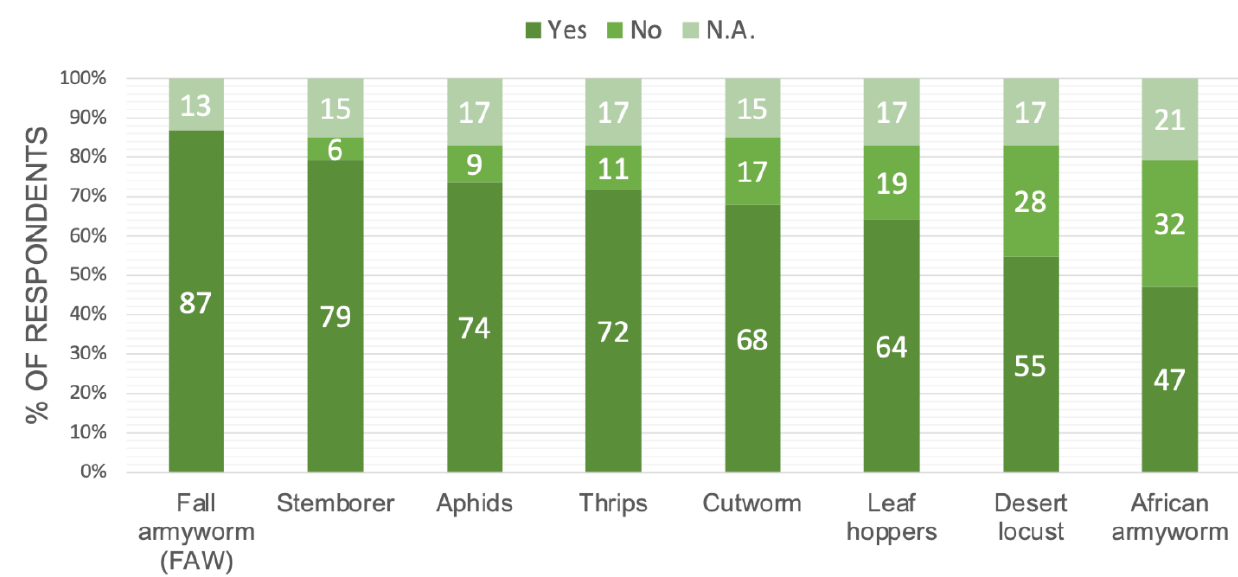
Figure 2. Percentages of respondents reporting pests in cereal crops in eastern Africa.